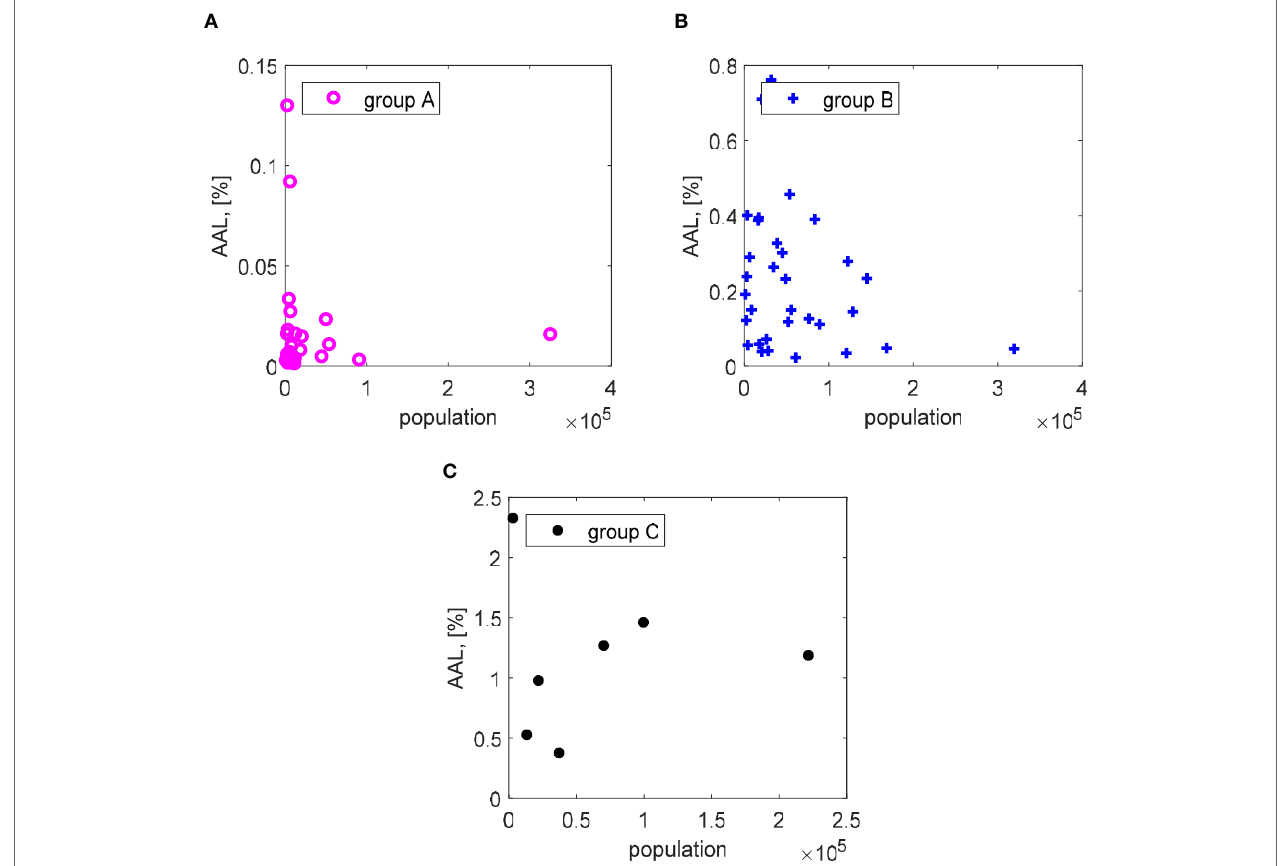
FigUre 4 | The average annual loss of the structure built before 1992 vs population: (a) Group A (120–130 mph), (B) Group B (140–150 mph), (c) Group C (160–180 mph).